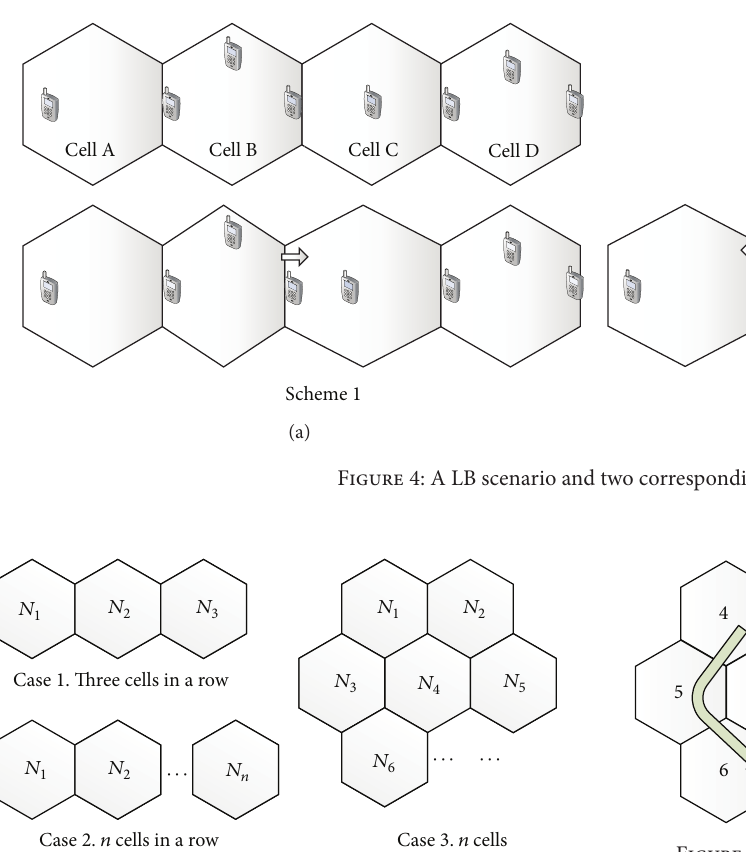
Figure 6: Two methods to mark 𝑛 cells with